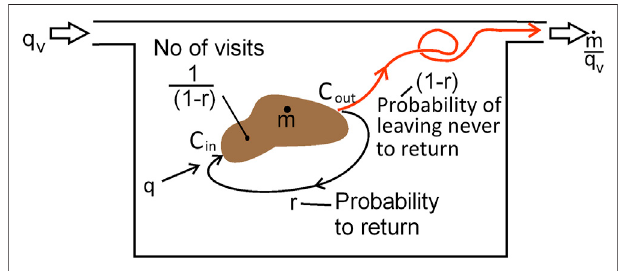
FIGURE 3 | Probabilities related to the two populations (Kato et al., 2003;Limet al.,2013;Lim et al.,2014;Chunget al.,2017;Lim et al.,2021).q is the standard fl ow rate (based on the velocity fi eld) in and out of the